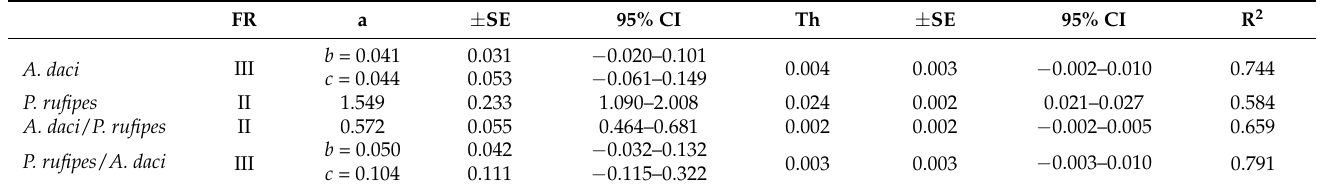
Table 2. Functional response type (FR), attack rate (a) (days − 1 ) and estimated handling time (T h ) (days) estimated from non-linear regression of the number of host/prey by Aganaspis daci mated females and Pseudoophonus rufipes adults acting alone (Experiments 1 and 2, respectively); and by A. daci mated females sharing the experimental unit with P. rufipes adults and vice versa (Experiment 3) (in all cases, assessed under laboratory conditions).